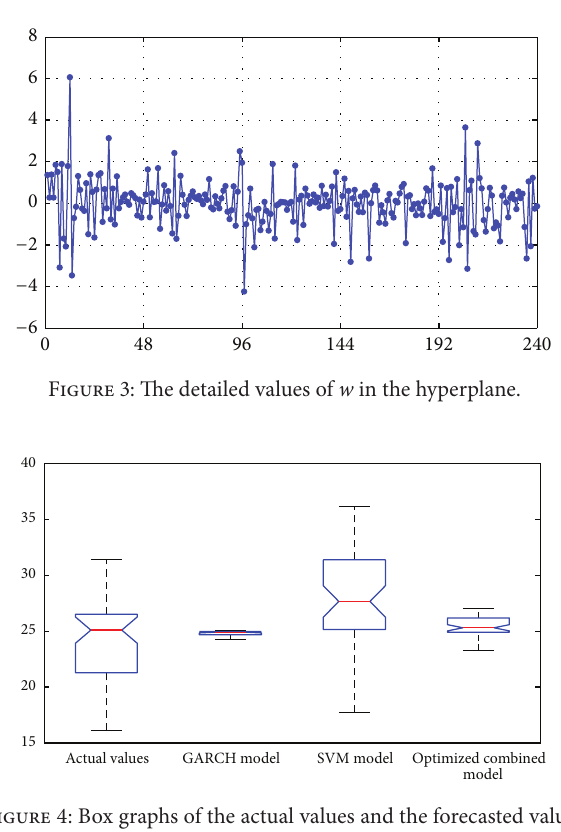
Figure 4: Box graphs of the actual values and the forecasted values by three